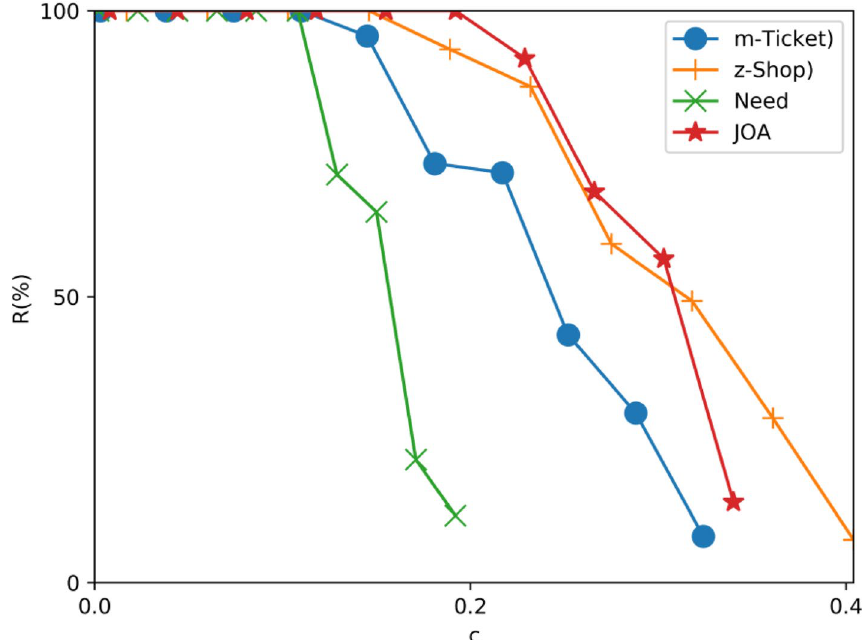
Fig. 6 The change trends of R with c in Experiment 1